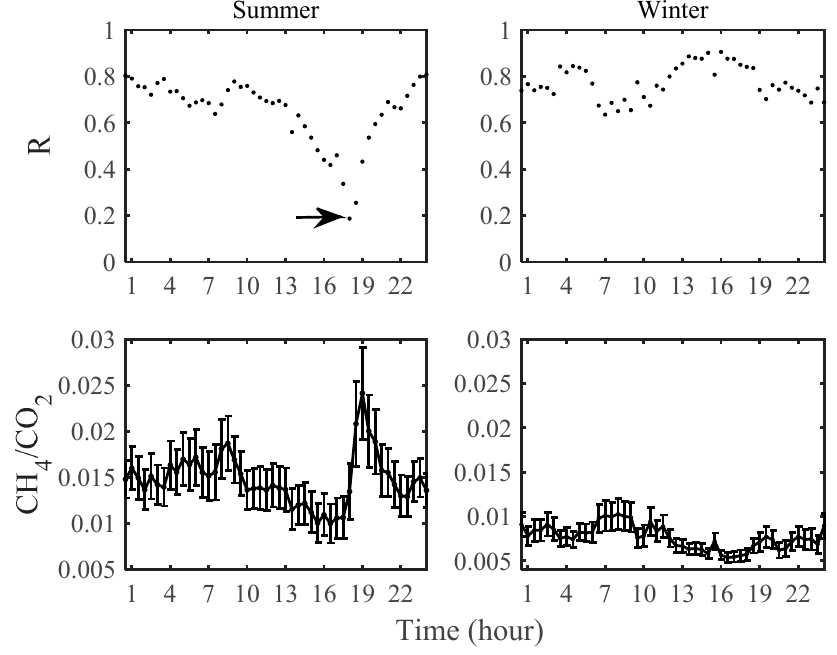
Figure 7. Diurnal variation of CH 4 :CO 2 emission ratio in the summer (June, July, and August) in 2014 and in the winter (December, January and February) during 2014–2015. The arrow indicates the linear correlation at the p value of 0.05.